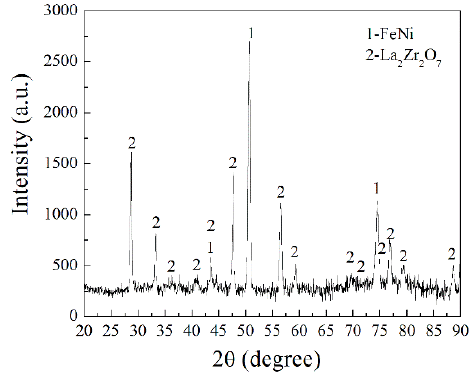
2 Zr 2 O 7 coating.